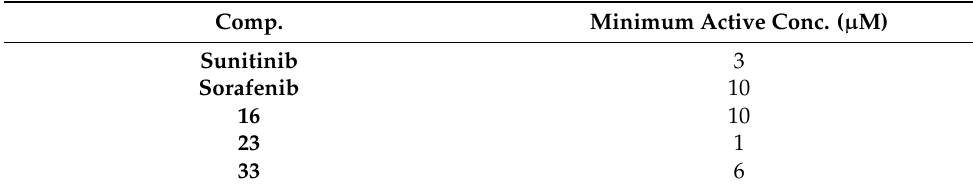
Table 3. Inhibition effect of tube formation. Comp. Minimum Active Conc. ( µ M) Sunitinib